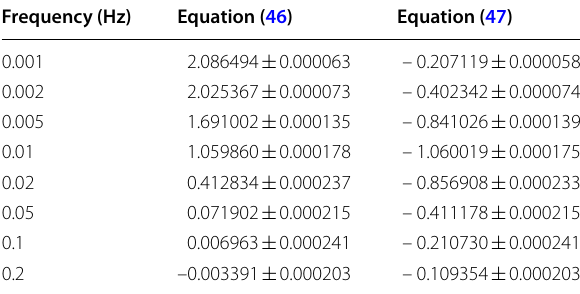
Table 1 Measurement results for the left-hand side of Eqs. (46) and (47) for eight different frequencies